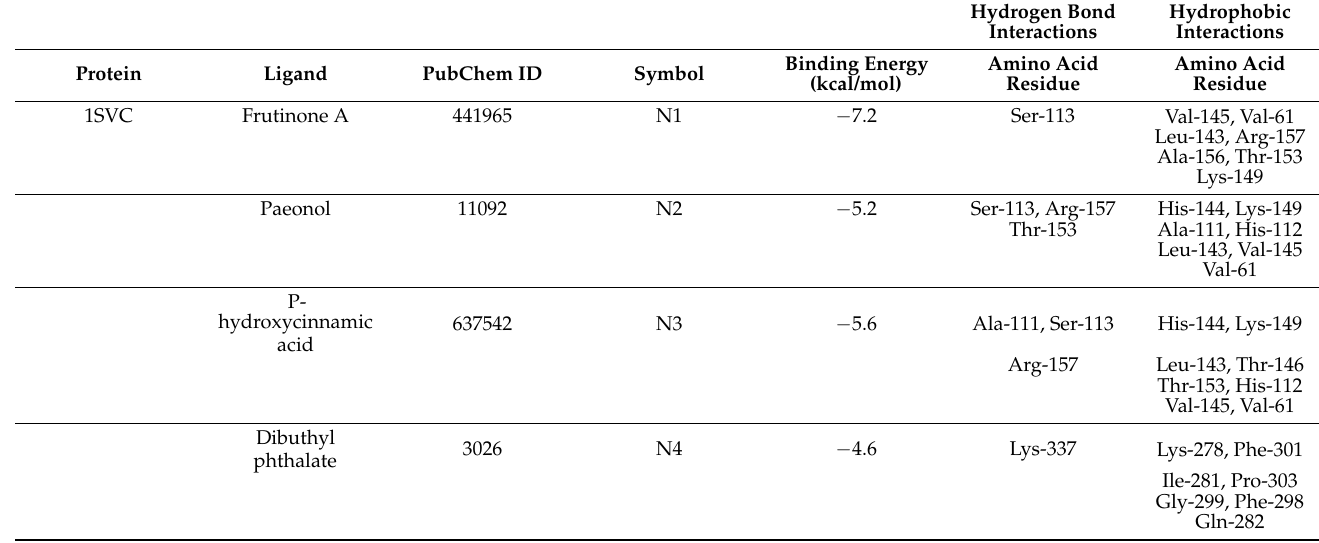
Table 4. Binding energy of potential active compounds on NFKB1 (PDB ID: 1SVC).